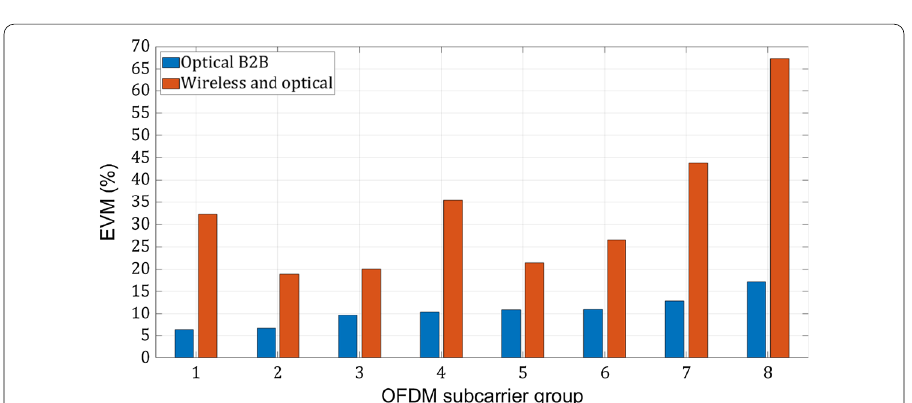
Fig. 5 Spectrum of the generated OFDM signal to be transmitted